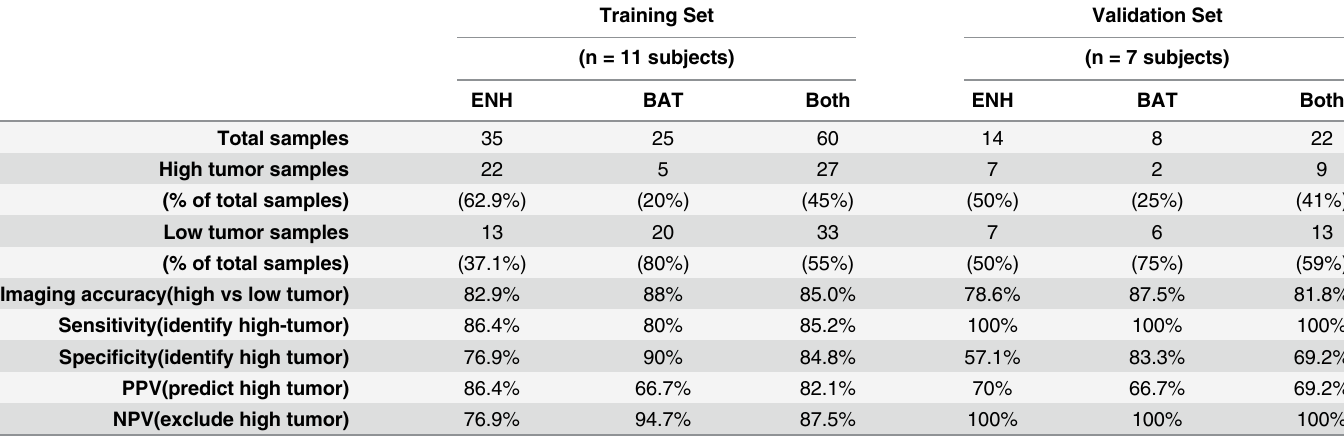
Table 1. Summary of tissue samples and test performance in both training and validation datasets.